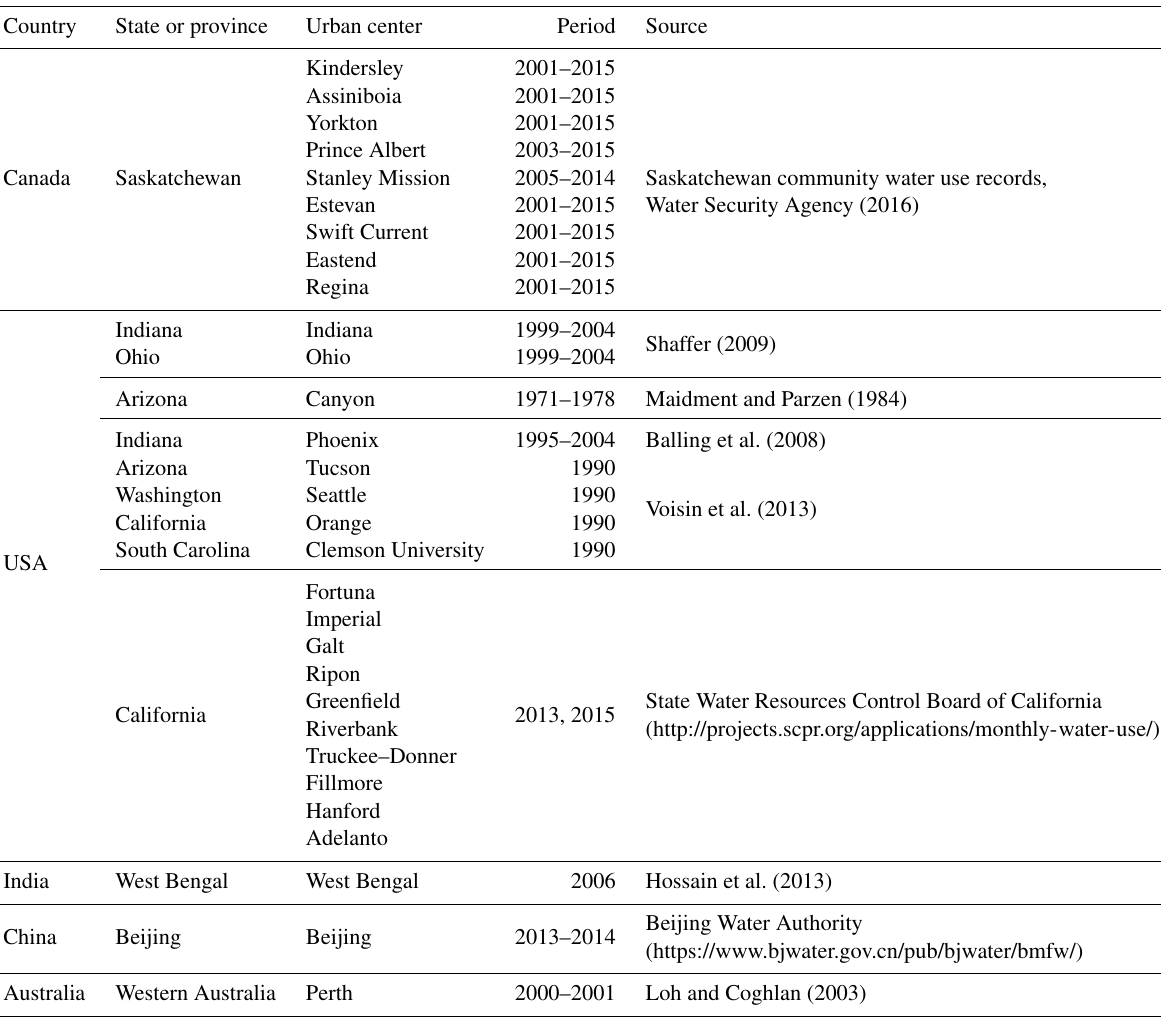
Table 2. Details of the observed monthly domestic water withdrawal for calibration of parameter R . Country